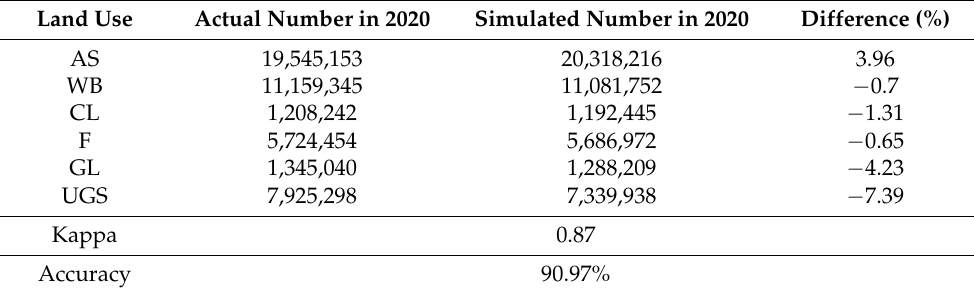
Figure 4. Actual (left) and simulated (right) land use patterns in Wuhan urban areas in 2020. Table 10. Simulated and actual cell number of different land use types in 2020. Land